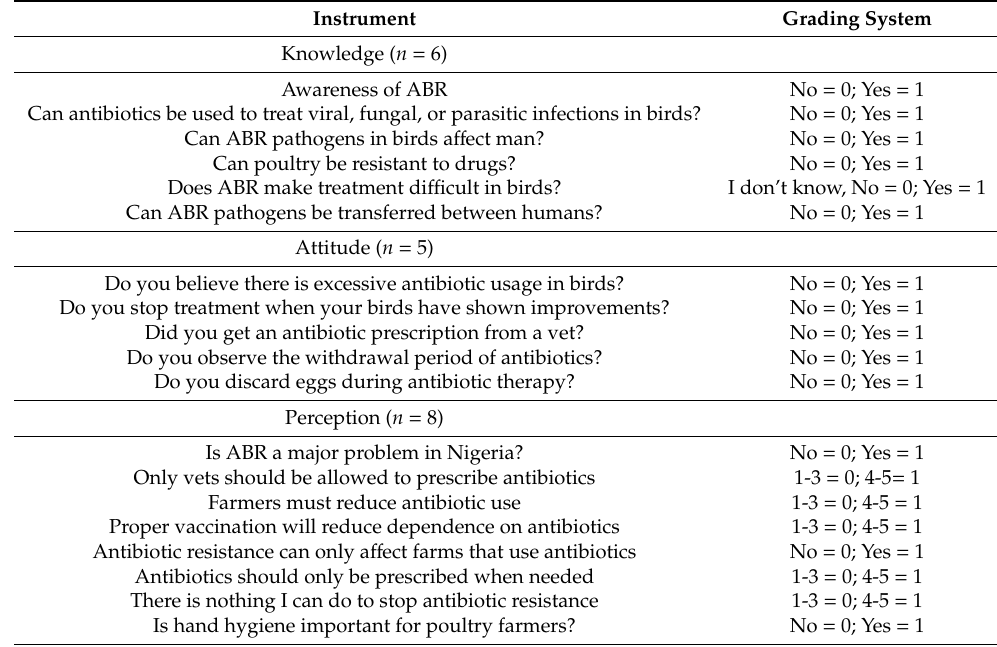
Table 1. The survey instrument and the numeric scoring system used to evaluate the knowledge, attitude, and perceptions of poultry farmers in Kwara state. Instrument Grading System Knowledge ( n = 6)